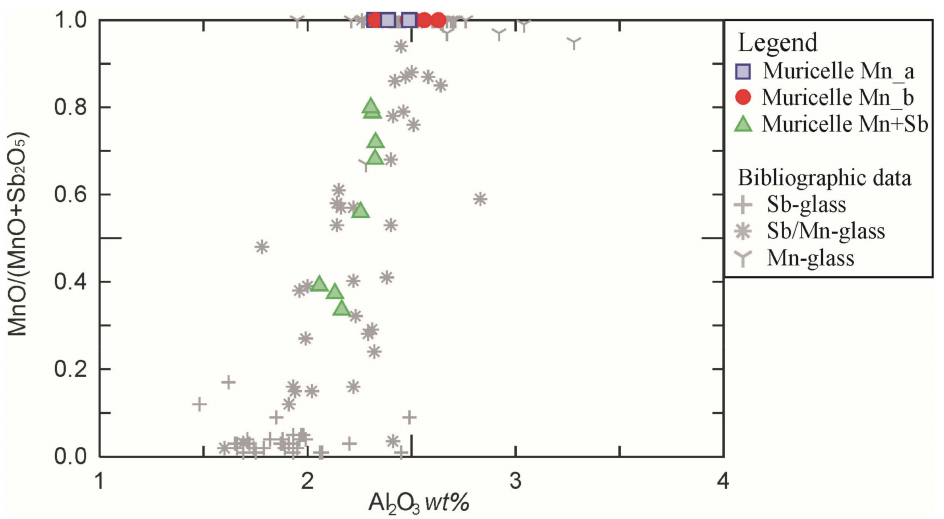
Figure 3. Al 2 O 3 versus MnO/(MnO + Sb 2 O 5 ) diagram. The bibliographic data refer to coeval Roman glasses [5,8,15,17,34].